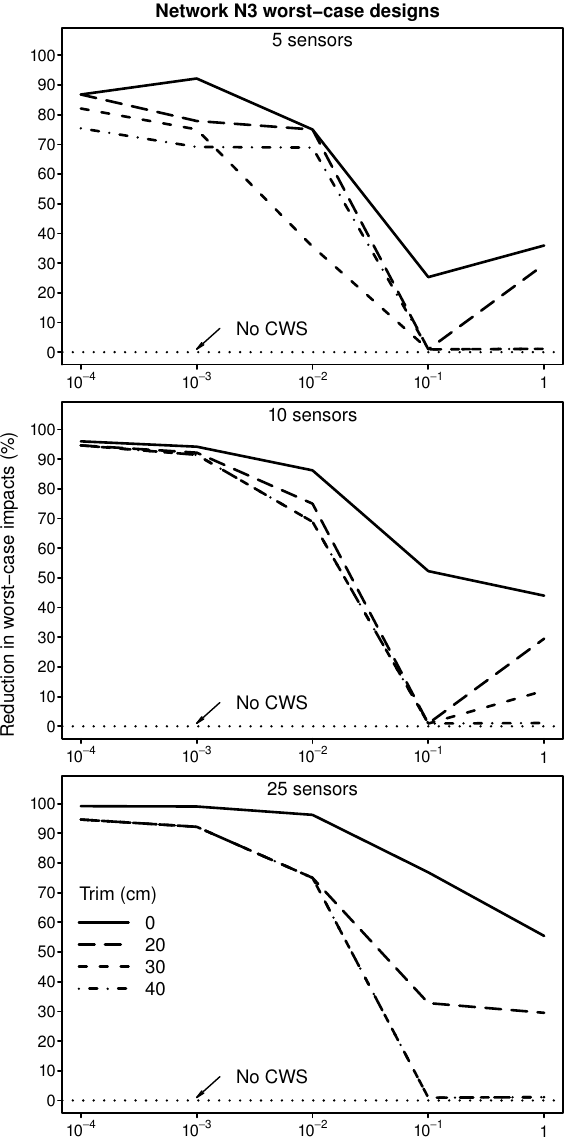
Figure 7. Reduction in worst-case impacts obtained with original and transplanted worst-case CWS designs for Network N3 relative to impacts obtained when no CWS is used. Results are shown for the original model and three levels of network skeletonization (trims).